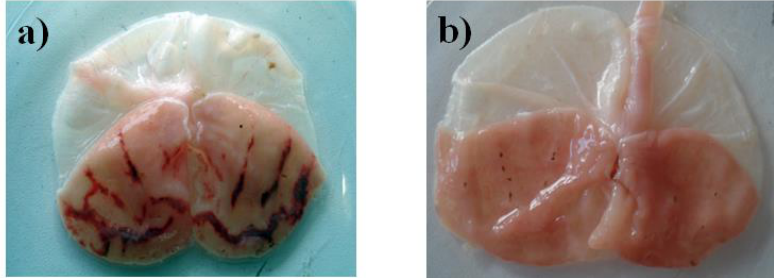
Figure 2 . Representative images of gastric mucosal lesions in rats treated with ( a ) the vehicle plus ethanol and ( b ) juanislamin plus ethanol.